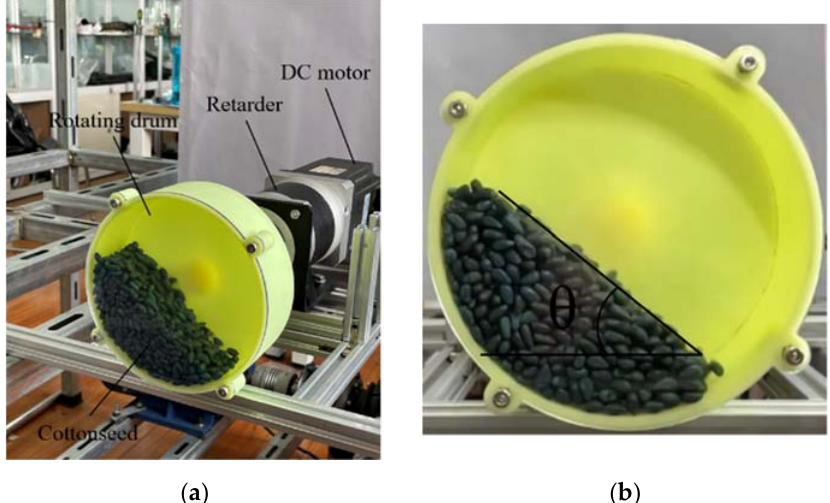
Figure 4. Determination of dynamic repose angle. ( a ) Dynamic repose angle measuring device; ( b ) seed stacking image. Note: θ is the dynamic repose angle of cotton seed, (°).